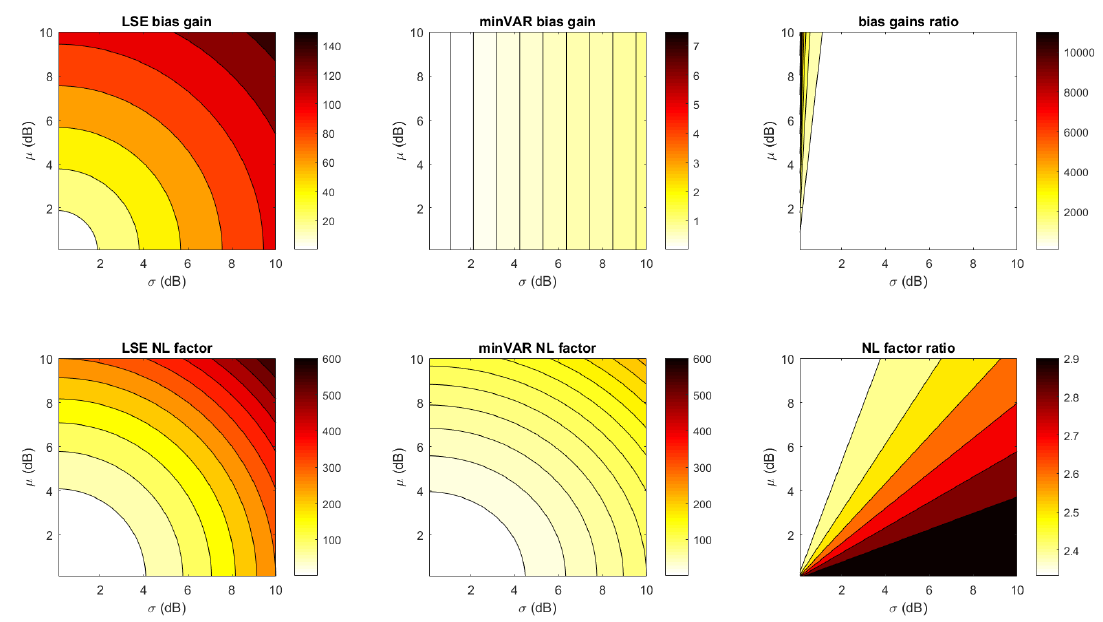
Figure 11. Estimator bias factors for both LSE and minVAR.